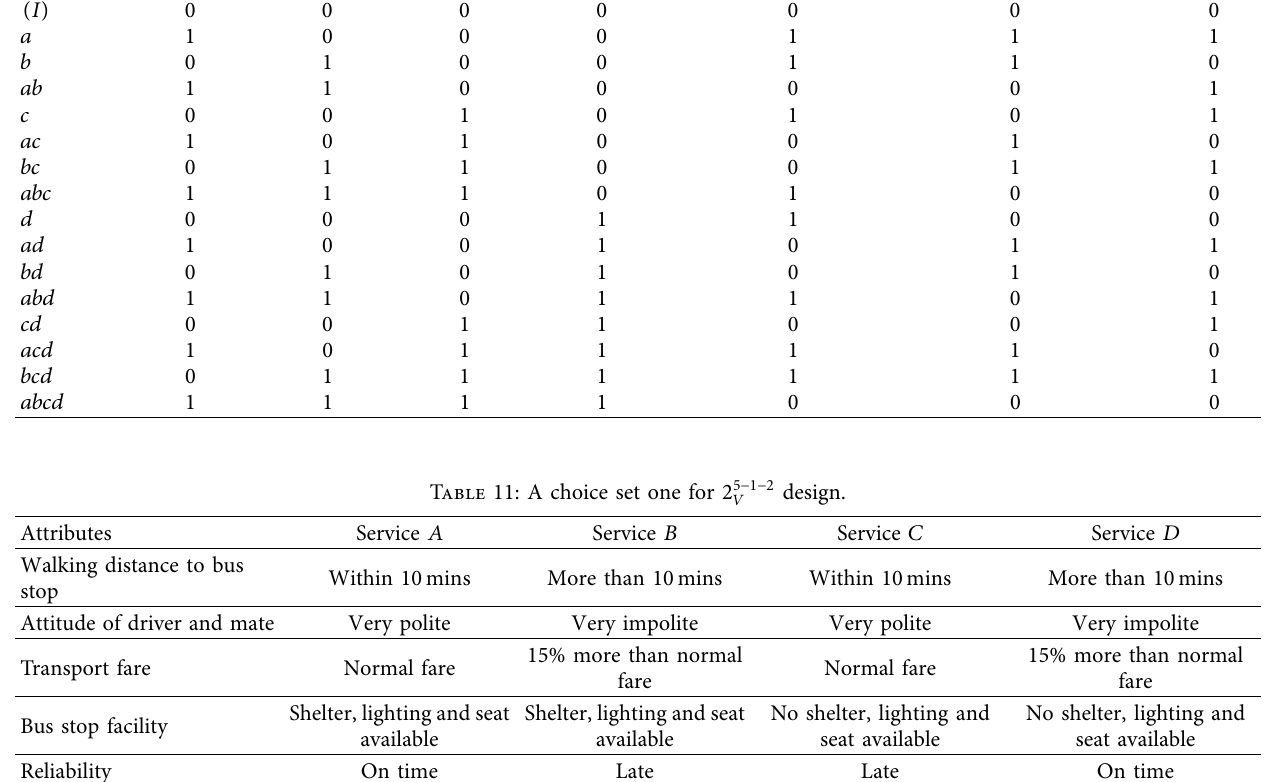
Table 10: Design matrix for 2 5 − 1 − 2